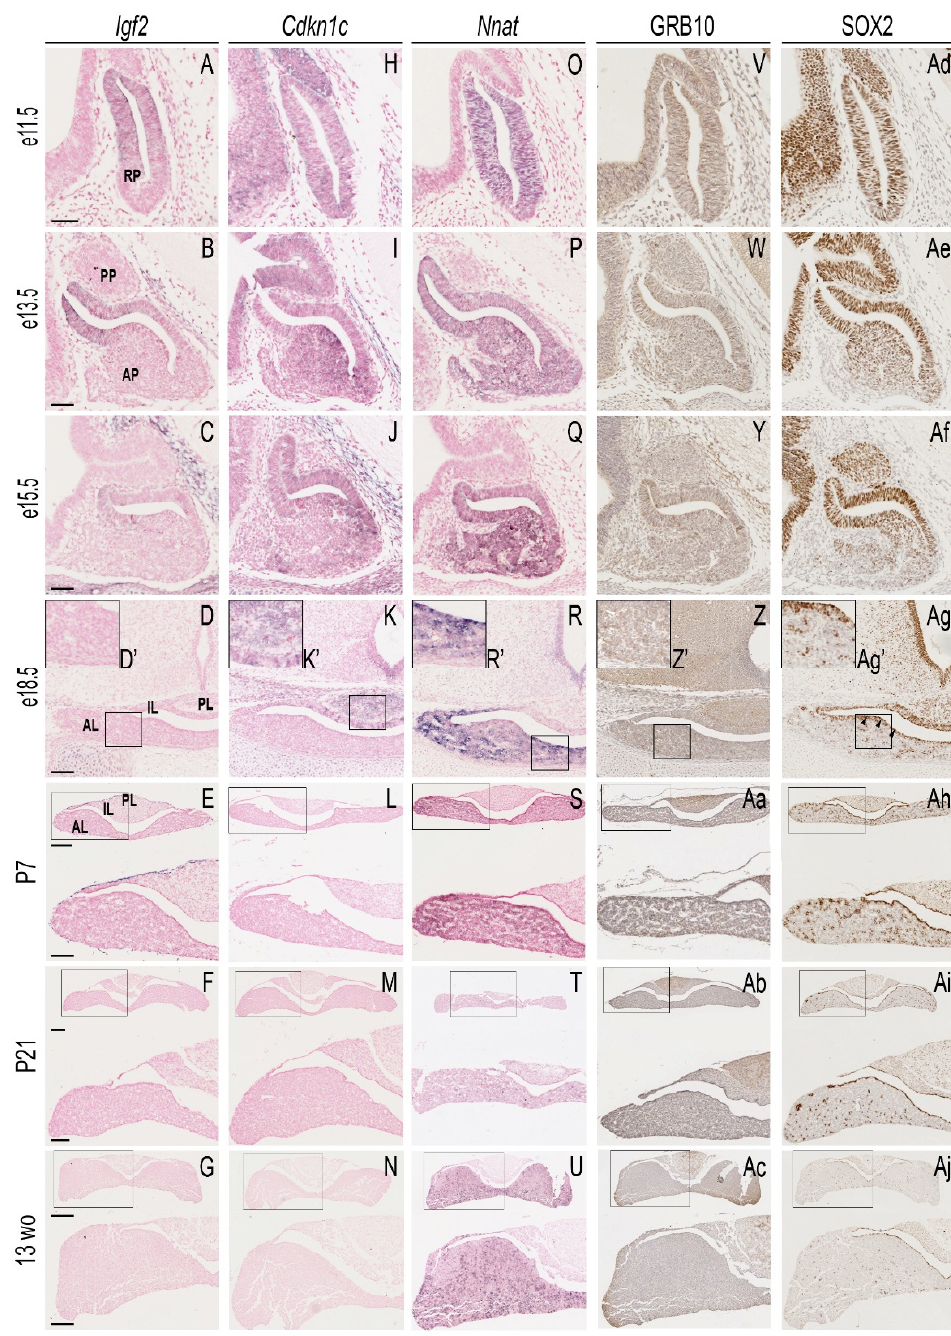
Figure 2. Expression of “embryo-high” imprinted genes in the developing and postnatal pituitary gland . In situ hybridisation (ISH) using antisense riboprobes against insulin growth factor 2 ( Igf2 ) ( A – G ), cyclin-dependent kinase inhibitor 1C ( Cdkn1c ) ( H – N ), neuronatin ( Nnat ) ( O – U ) and immunohistochemistry (IHC) against growth-factor receptor bound protein 10 (GRB10) ( V–Ac ) and sex-determining region Y-related HMG box 2 (SOX2) ( Ad–Aj ) on the histological sections of wild-type pituitary glands collected at different developmental and postnatal stages. Samples at e11.5-e15.5 were cut sagittally, and embryos at e18.5 and postnatal samples were cut frontally. Postnatal pituitary glands were collected from female animals. D’ , K’ , R’ , Z’ and Ag’ represent magnifications of the squared areas in D, K, R, Z and Ag, respectively. For the P7, P21 and 13-weeks-old (wo) rows, each picture contains a full image of the pituitary gland at the top and the magnified image of the boxed area at the bottom. Igf2 showed expression around the cleft at e11.5 ( A ) and in the rostral tip of the anterior pituitary (AP) at e13.5 (arrowheads in B ), but no expression was detected at later stages ( C – G ). Similarly, Cdkn1c showed expression during embryonic development ( H – K ), but no staining was observed for later stages ( L – N ). Cdkn1c staining was also observed in the infundibulum (Inf) ( H ). Staining was observed at e11.5 along the cleft and in the caudal area of the anterior pituitary at e13.5 and e15.5 (arrows in I – J , respectively), and in the posterior lobe (PL) and intermediate